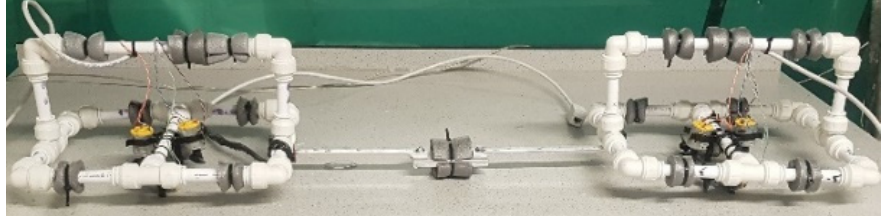
Figure 2. System of two Seaperch UUVs connected to a plated payload via plated manipulators (RCTS).